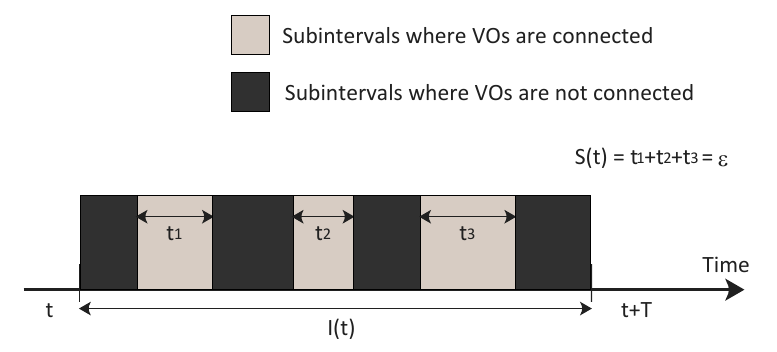
Figure 5. Communication constraints for the consensus algorithm to converge